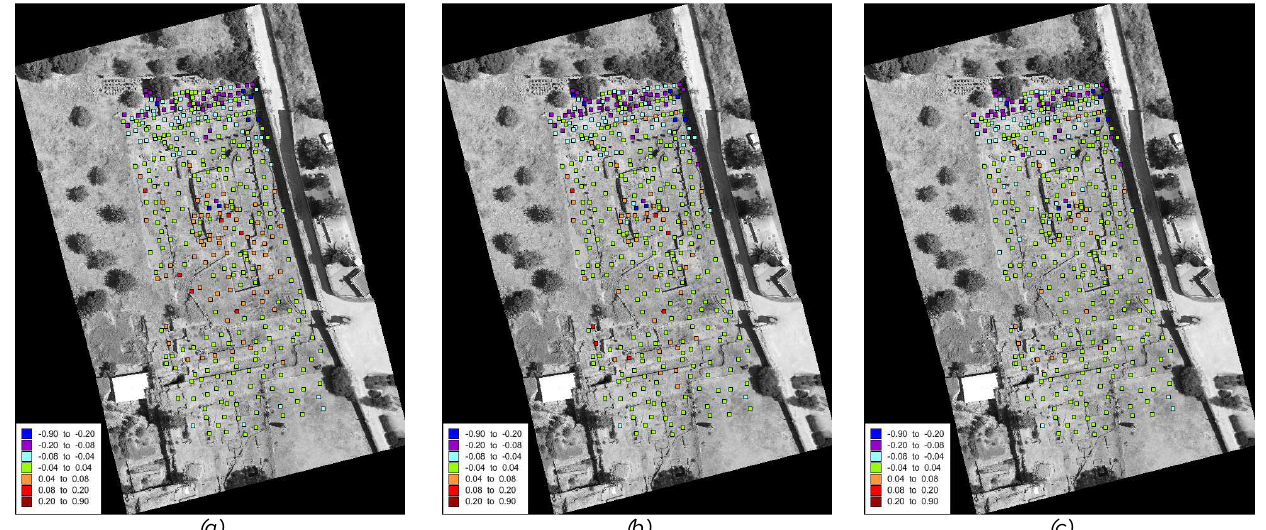
Figure 10. Graphic representation of the vertical differences (in m) in 3D point cloud evaluation for the Temple of Isis: : East-West